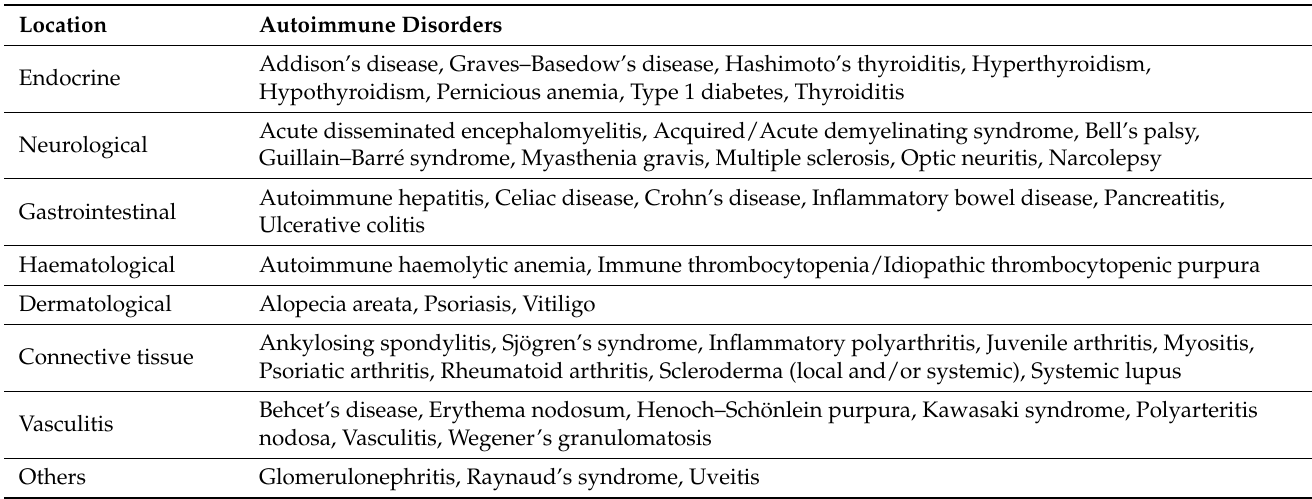
Table 2. Examined autoimmune disorders classified to